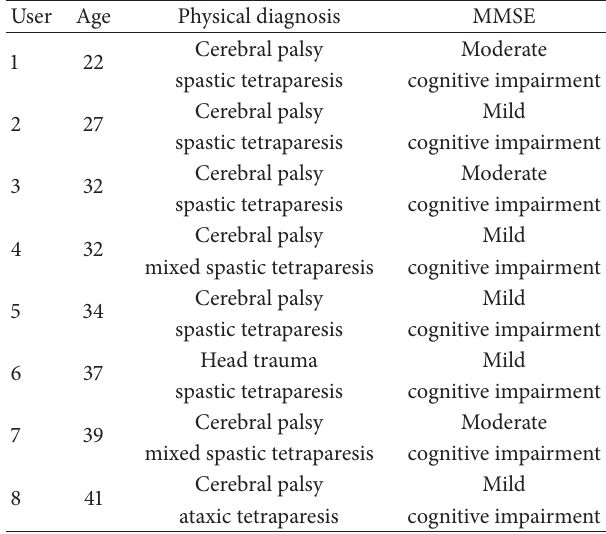
Table 1: Characteristics of